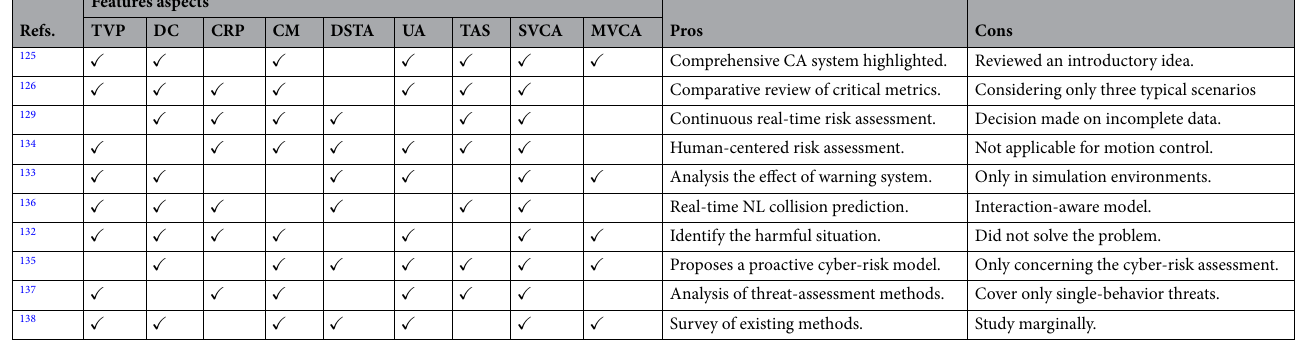
Table 6. Reviewed up-to-date papers according to SVC and MVCs threat assessment in AVs. TVP Threats of in-vehicle protocol, DC Driving comfort, CRP Collision risk prediction, CM Collision mitigation, DSTA Dynamic and static threat assessment, UA Uncertainty assessment, TAS Threat assessment strategies, SVCA Single vehicle collision avoidance, MVCA Multiple vehicle collision